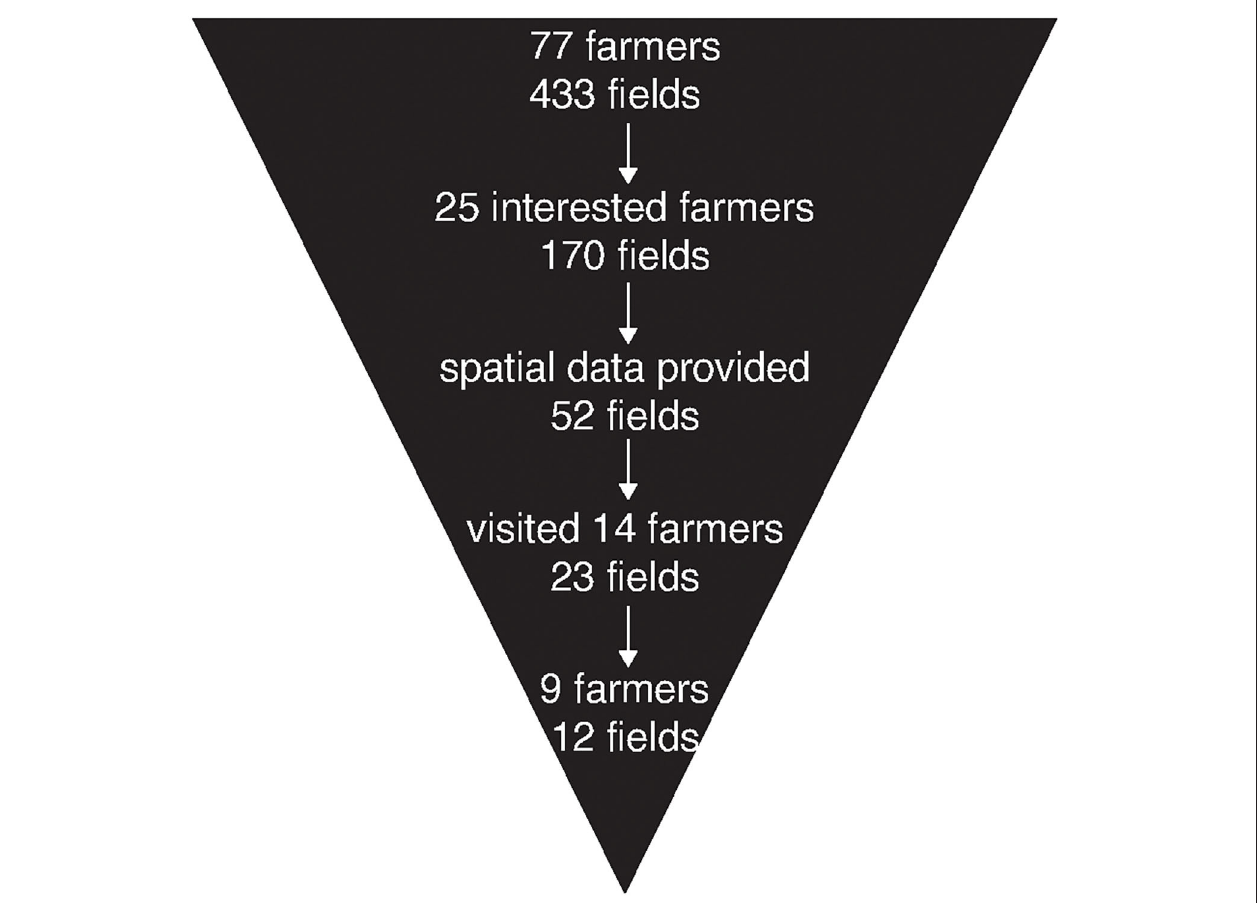
FIGURE 3 | The process of finding elevated-P fields for BMP implementation and monitoring. Initially, 77 farmers were contacted to find interested participants. A selection of potential sites was chosen from the pool of interested farmers and spatial information was requested on these fields. Following a hydrological assessment using the spatial data, fields were visited to assess the suitability of a practice at each site. Ultimately, 12 fields were identified for monitoring and BMP